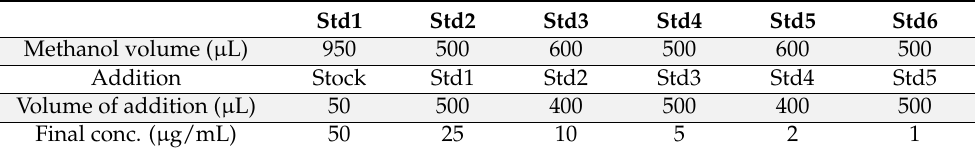
Table 3. Standards preparation scheme from the stock solution. Standard solutions were prepared from a serial dilution from the stock solution, resulting in standards with concentrations ranging from 1 to 50 µ g/mL. Std1 Std2 Std3 Addition Stock